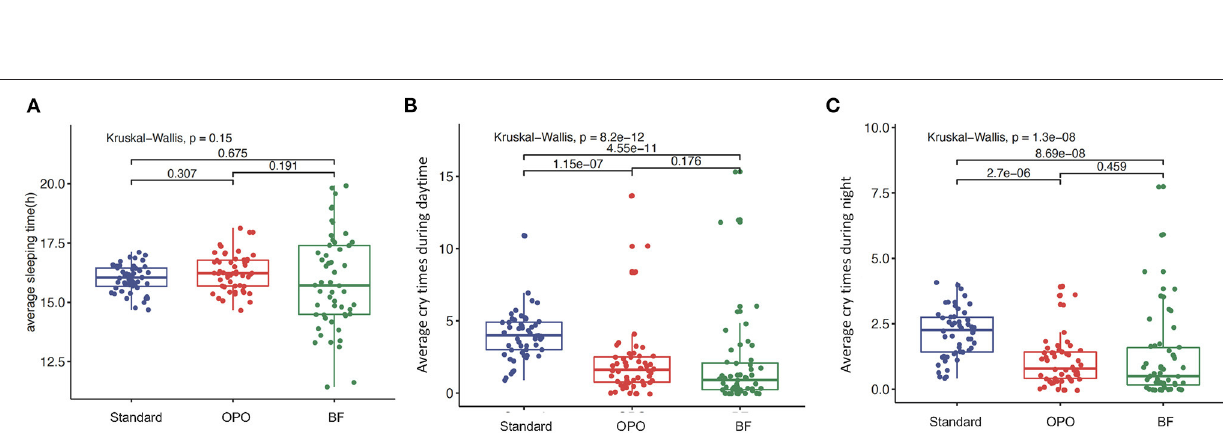
Frontiers in Pediatrics | www.frontiersin.org